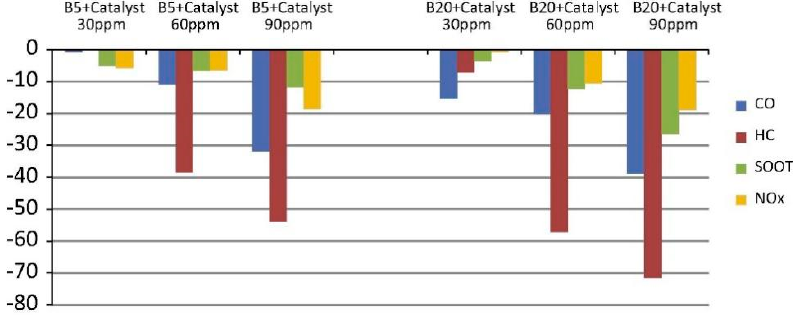
Figure 13. Overall decrease in emissions of carbon monoxide (CO), hydrocarbon (HC), soot and NO x achieved by addition of the CeO 2 -MWCNTs nanocatalyst compared to catalyst-free fuels [113].